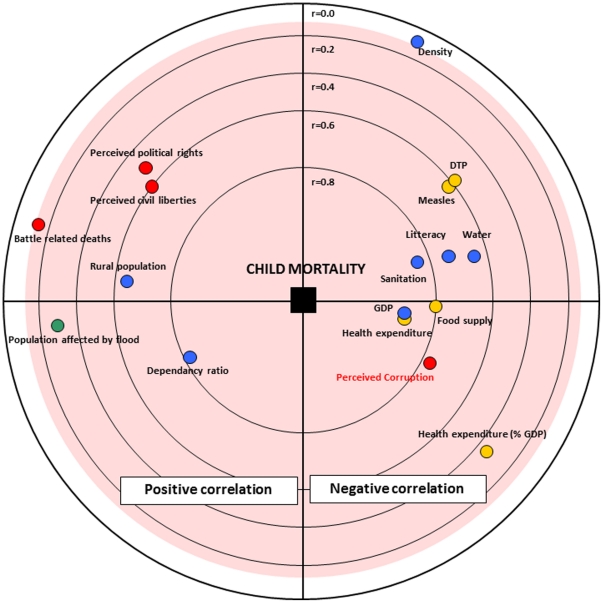
Pearson's correlations between the mortality rate in children and the other variables used in the analysis.Representation obtained with a Focused Principal Components Analysis. Pearson's correlations between the mortality rate in children and the other variables are represented faithfully. Positive correlations with child mortality are plotted on the left and negative ones on the right. Correlations which are significantly different to zero are inside the pink circle. The relationships between the other variables are interpreted like in a PCA: correlated variables are close or diametrically opposite (for negative correlations), independent variables make a right angle with the origin. Colours indicate the nature of explicative variables (red: political and societal factors, blue: socio economic factors, orange: health and medical factors and green: environmental factors).